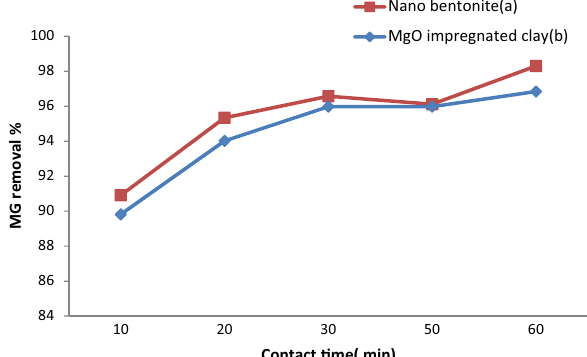
Figure 8. Effect of contact time on MG dye removal by ( a ) nano bentonite and ( b ) MgO impregnated